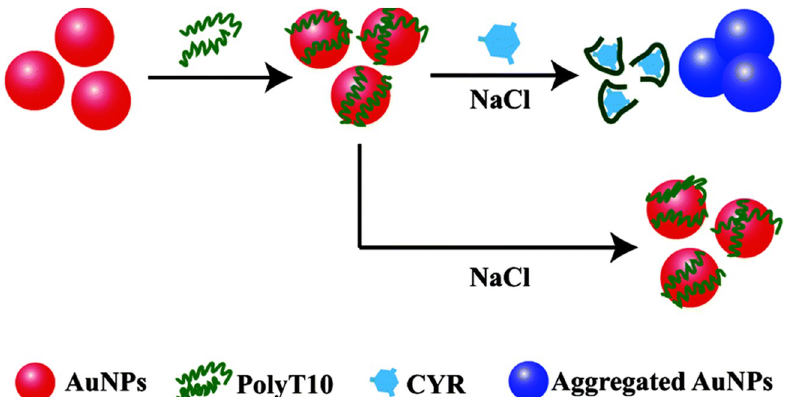
Figure 5. Label-free gold nanoparticle (AuNP) colorimetric sensor for optical detection of cyromazine. Reproduced with permission from reference [110].